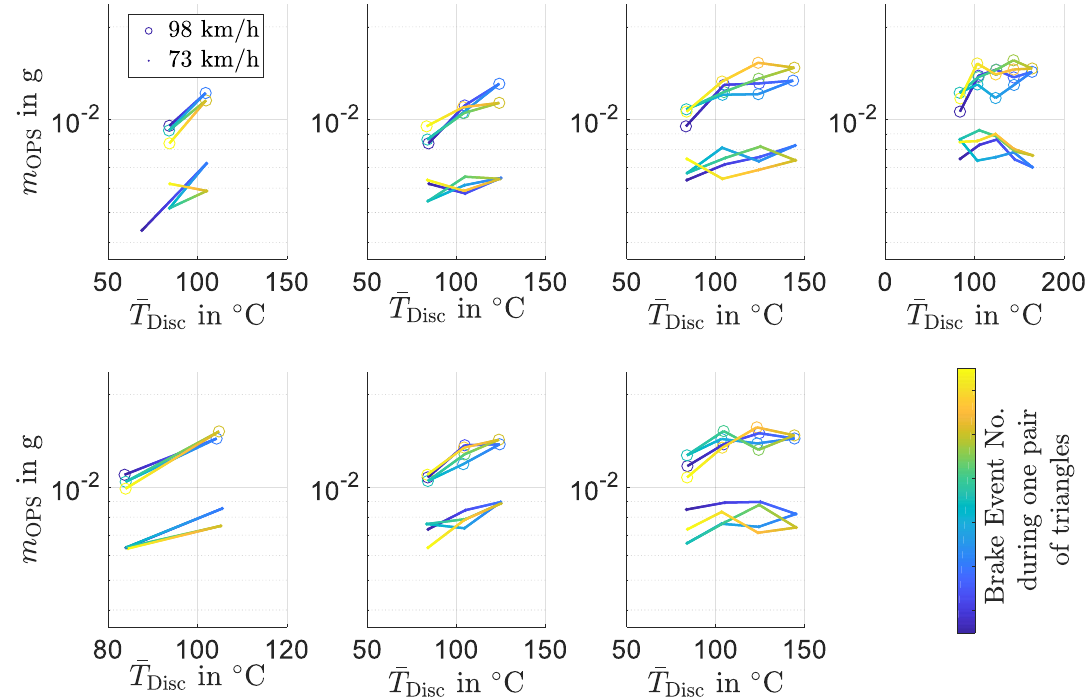
Figure 11. PM 10 emissions per brake event averaged for each temperature step of the pad material with an organic binder and the operating point pair 2&3 (73 and 98 km/h).